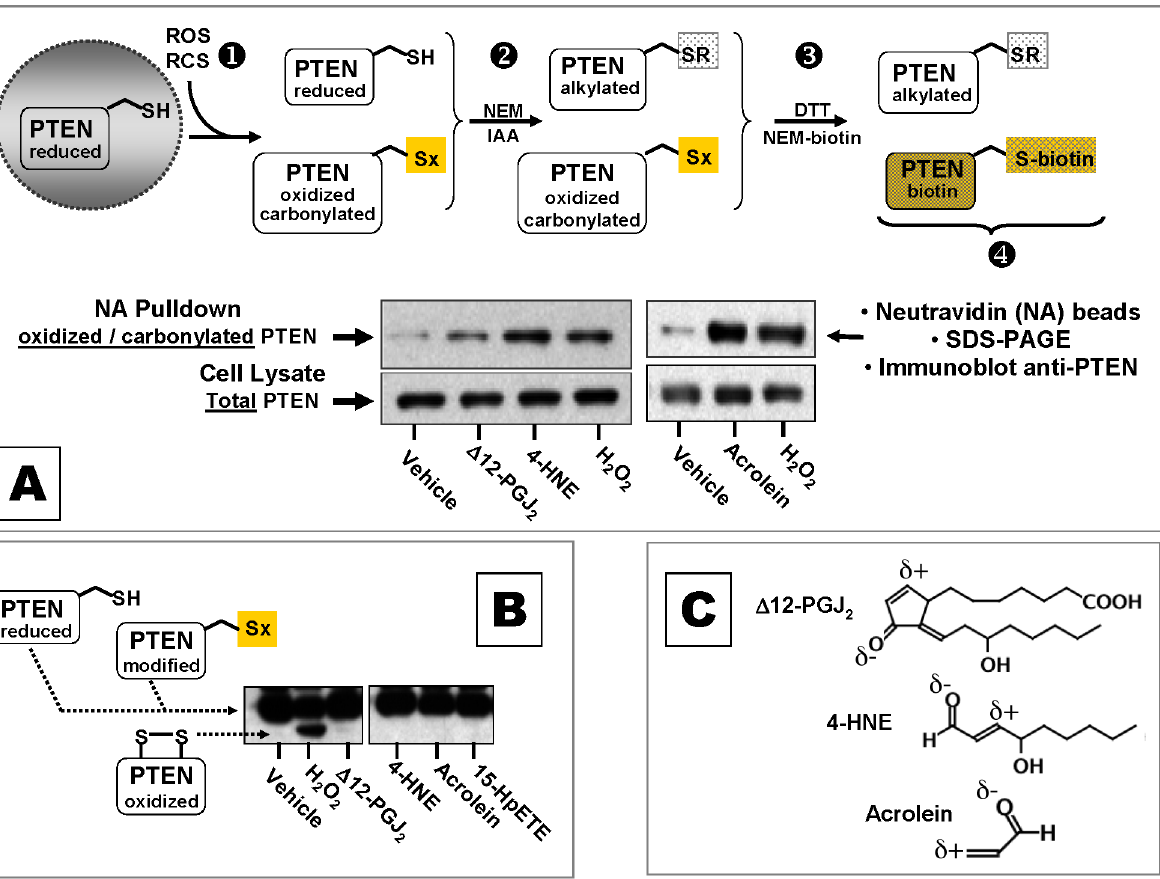
Figure 1. a , ß–unsaturated carbonyls covalently modify cellular PTEN. ( A ) Diagram of the procedure to identify PTEN with an oxidized or alkylated thiol in cells exposed to ROS or a , ß–unsaturated carbonyls. The anti-PTEN immunoblot shows oxidized or carbonylated PTEN (NA Pulldown) relative to total PTEN (Cell Lysate) isolated from MCF-7 cells treated 30 min with vehicle (DMSO), 10 m M D 12-PGJ 2 or 4-HNE versus 10 min with 100 m M H 2 O 2 ; an immunoblot from a separate experiment shows oxidized, carbonylated and total PTEN in cells treated for 30 min with vehicle or 20 m M acrolein versus 10 min with 100 m M H 2 O 2 . ( B ) Anti-PTEN immunoblot of MCF-7 cell lysates fractionated by SDS-PAGE under non-reducing conditions. PTEN oxidized to a Cys 124 -Cys 71 disulfide appears as a faster migrating species (PTEN oxidized disulfide) only in cells treated with H 2 O 2 . This species was undetectable in MCF-7cells treated 30 min with DMSO vehicle or 20 m M each D 12-PGJ 2 , 4-HNE, acrolein or 15-HpETE. ( C ) Chemical structures of typical a , ß–unsaturated carbonyls. Acrolein and 4-HNE are a , b enals; D 12PGJ 2 is an a , b enone. Electrophilic b carbons are denoted with d + . Blots are representative of results obtained in at least three independent experiments.